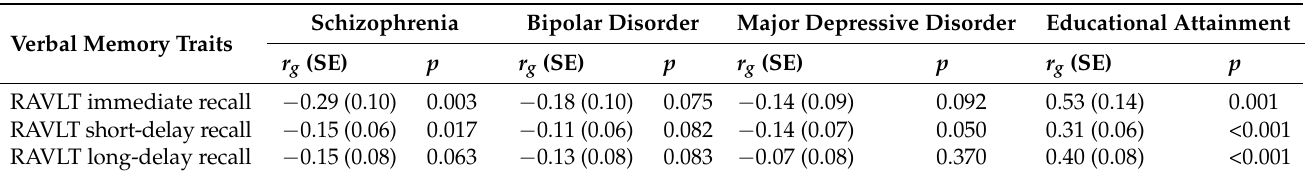
Table 3. Genetic correlations between three verbal memory traits and relevant psychiatric traits or educational